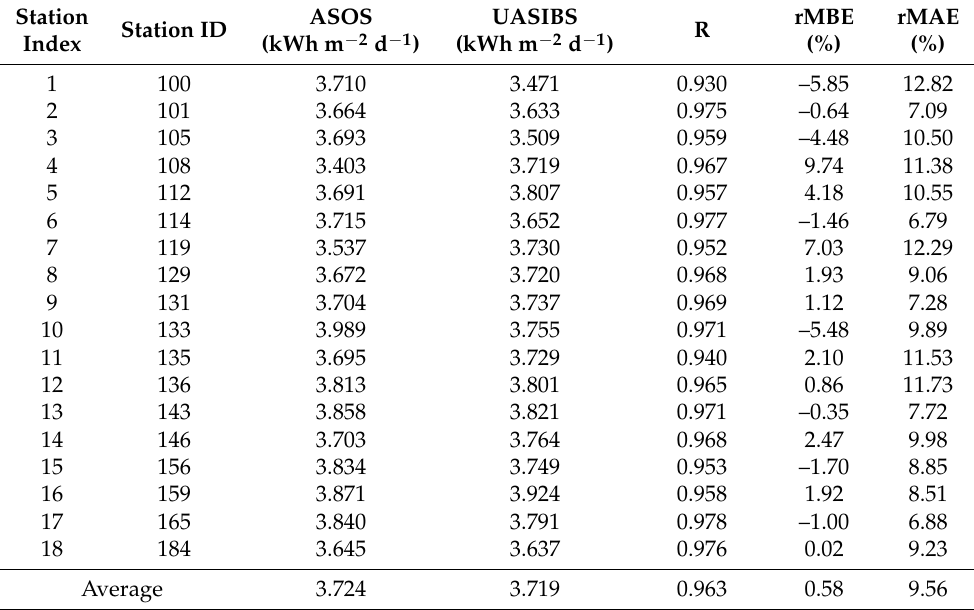
Figure 2. Scatter plot of the monthly mean of daily total irradiance between the ground observation (ASOS) and the satellite estimates (UASIBS) with probability density function of frequency for each dataset. The red dotted line indicates the reference line for perfect correlation. Table 3. Summary of the relative mean bias error (rMBE, %) and root mean square error (rRMSE, %) for the hourly mean estimations from the UASIBS/KIER and KMA-INS models for the 18 KMA ground